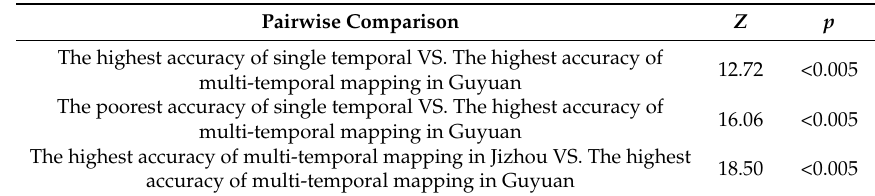
Table 12. Z -test values for the pairwise comparison of the error matrices. Pairwise